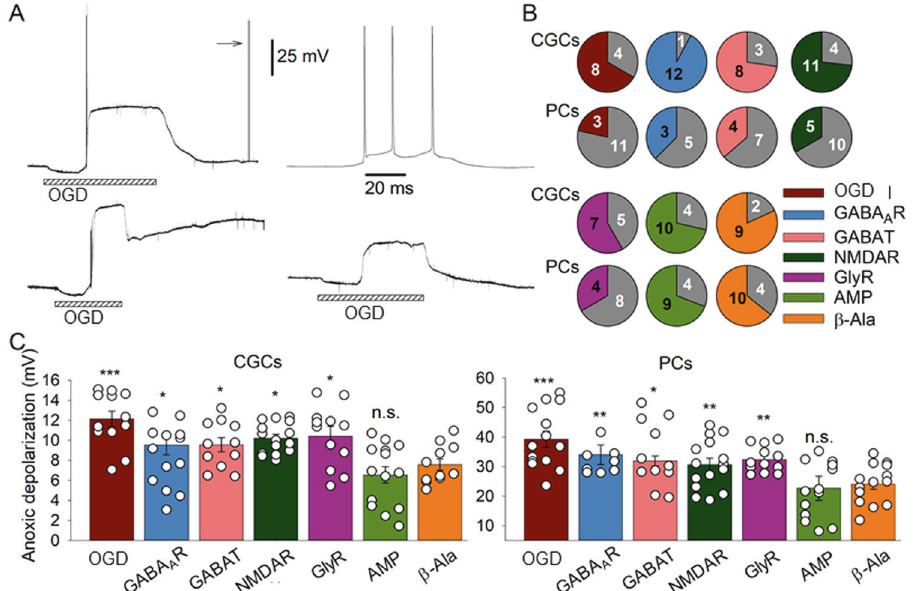
Fig. 4 β -Ala alleviates the OGD-induced anoxic depolarization (AD) in CGCs and PCs by simultaneously targeting GABA A Rs, NMDARs, GlyRs, and GABA transporters. A Examples of the OGD-induced AD recordings. Top: a cell recovered its membrane potential after an OGD episode back to a control level. Note spontaneous APs of typical kinetic pro fi le evoked post-OGD (arrow mark) to con fi rm functional recovery. Top right: recorded spontaneous APs shown at an expanded time scale. Bottom left: a cell failed to restore its membrane potential after the OGD-induced AD. Bottom right: in the presence of β -Ala, a cell displayed a lower AD amplitude and recovered its membrane potential post- OGD. Bars at the bottom mark a 15-m OGD episode, 25 mV scale bar apply to all traces. B Summary of the proportion of CGCs and PCs that recovered their membrane potential after the OGD-induced AD or not recovered (gray color). The number of cells indicated (total n = 8 – 15 for each test, 10 – 13 animals/group). Charts are color-coded for the selective activation of different receptors or β -Ala as denoted. AMP ( β -Ala mimicking protocol) includes simultaneous activation of GABA A Rs, NMDARs, GlyRs, and GABA transporters using the concentrations of selective ligands equipotent to the β -Ala effect. C Statistical summary of the OGD-induced AD amplitude in CGCs (left plots) and PCs (right plots) in different experimental conditions (color-coded): in the presence of β -Ala or selective receptor agonists used separately or simultaneously. * P < 0.05, ** p < 0.01, *** p < 0.001, n.s. non-signi fi cant compared to the effect of β -Ala (Student ’ s t -test); total n = 8 – 15 cells/8 – 11 animals tested per